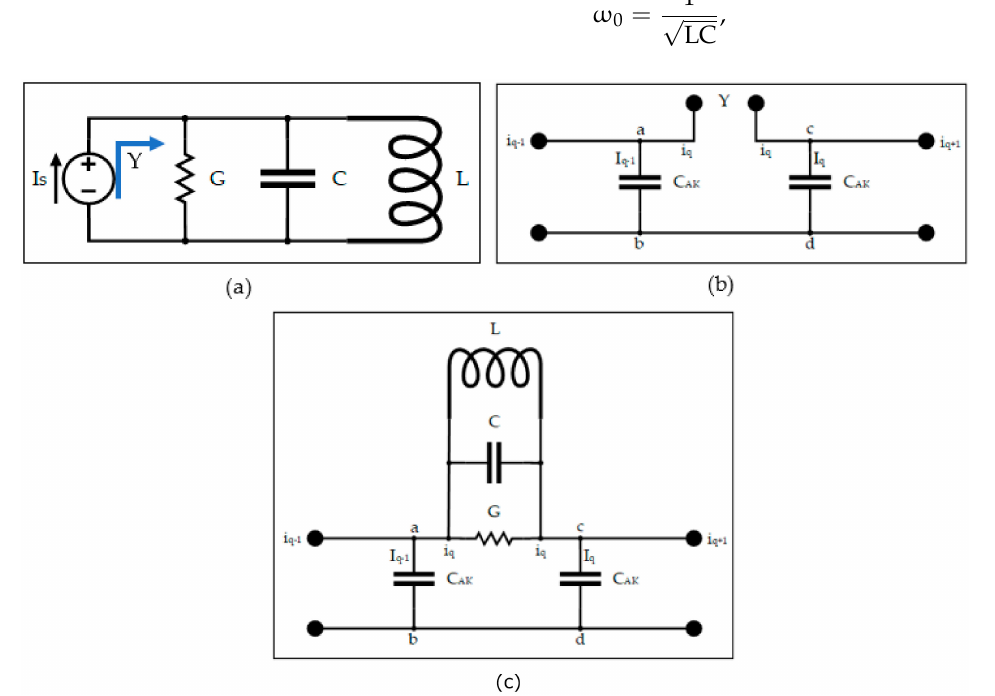
Figure 5. The equivalent resonant circuit network of the magnetron. ( a ) The equivalent circuit for the side resonators; ( b ) the equivalent circuit for the interaction space; ( c ) the equivalent circuit of the